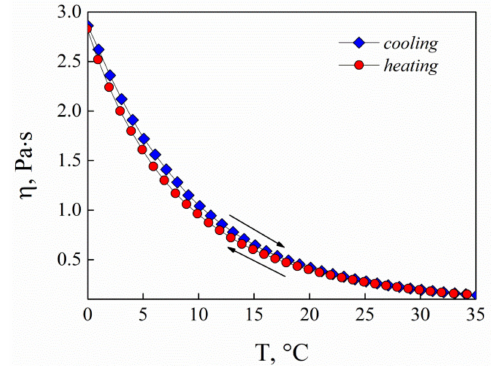
Figure 2. Temperature dependence of the North Sea crude oil viscosity under cooling and heating at a heating-cooling rate of 1